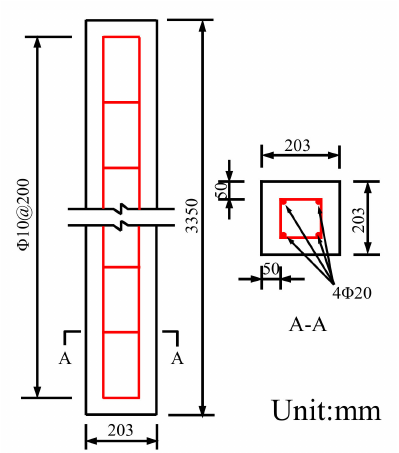
Figure 1. The evolution and cross-section and reinforcing details of NSC1.